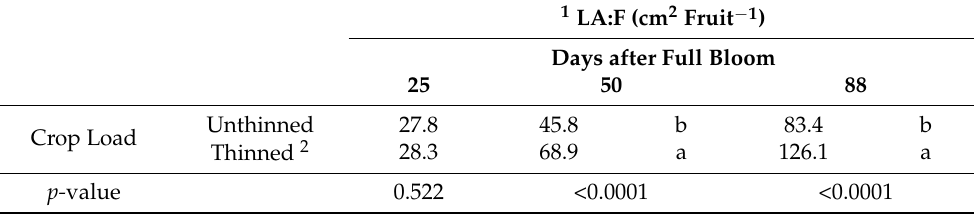
Table 3. Leaf area-to-fruit ratio (LA:F) in the sweet cherry combination ‘Lapins’/‘Colt’ for two levels of crop load: (1) unthinned (natural crop load) and (2) thinned (50% of fruit removed, 31